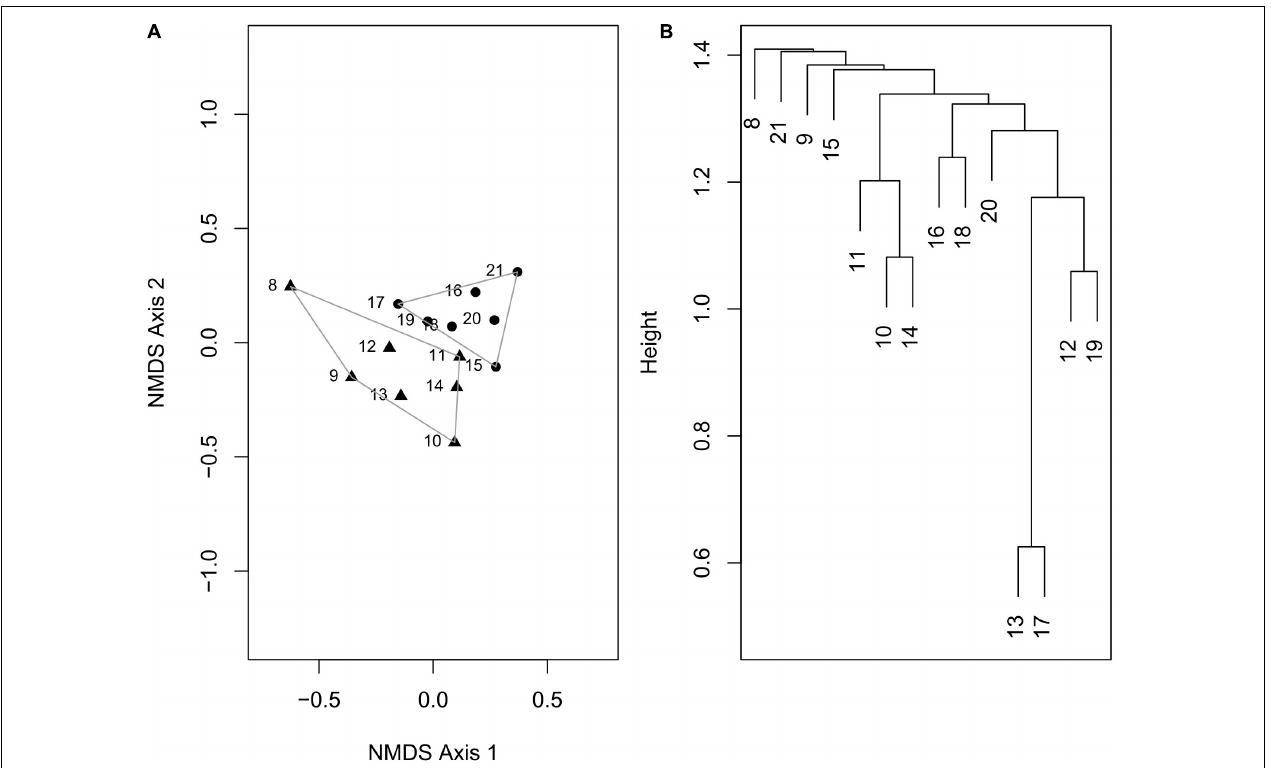
FIGURE 5 | (A) Ordination plot using non-metric multidimensional scaling, based on Bray–Curtis distance calculated from a matrix of marine bivalve species at different latitudinal bins. (B) Dendrogram constructed by UPGMA method using arithmetic averages.